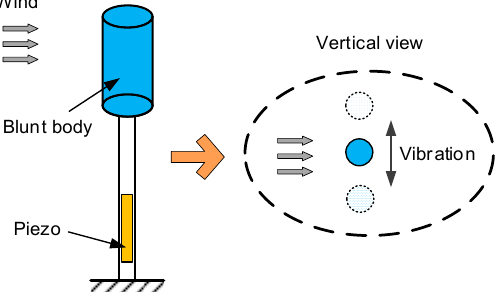
Figure 4. Wind-induced vibration device.